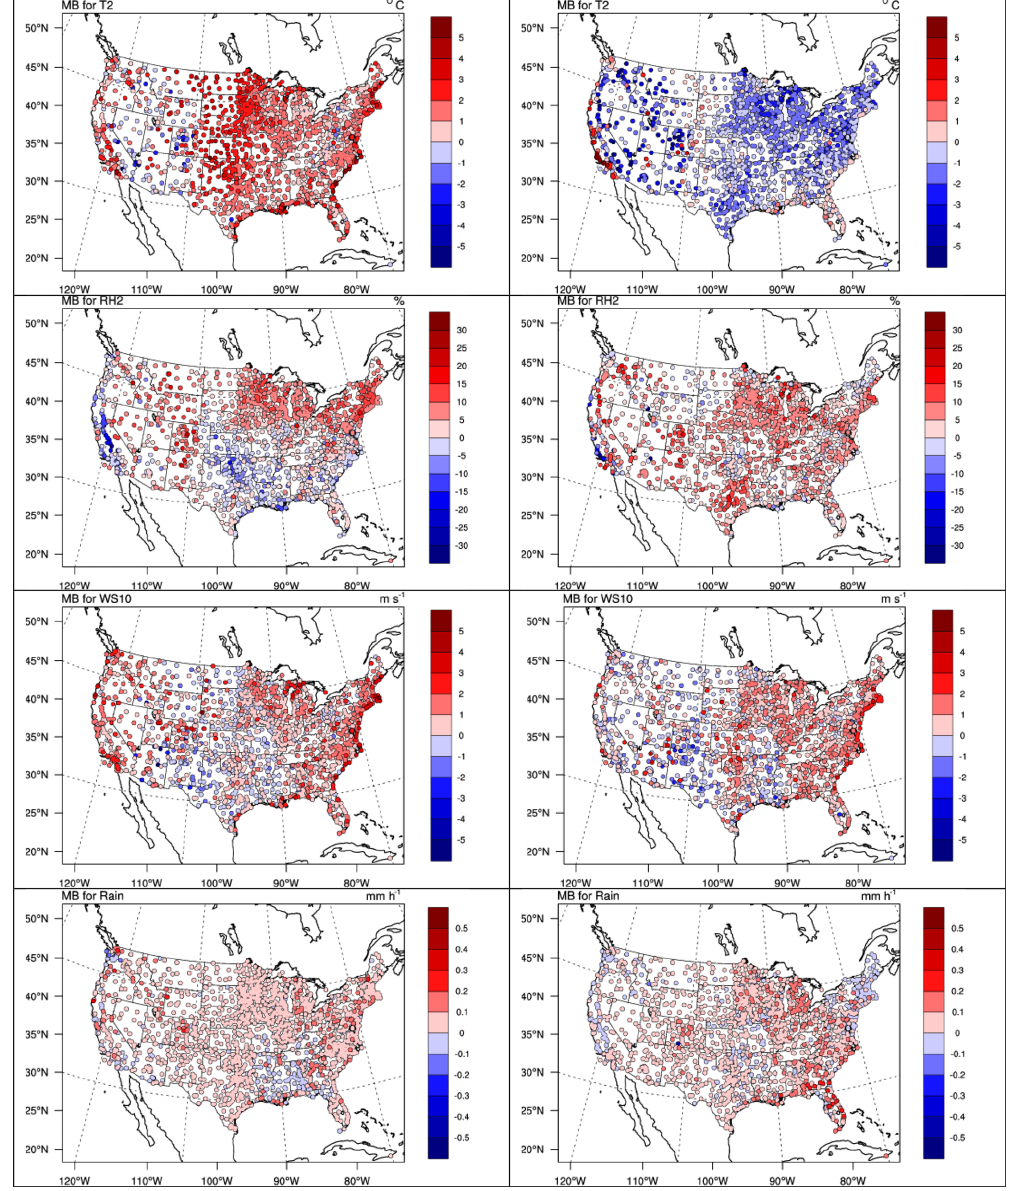
Figure 1. Spatial distributions of 5-year average MBs for 2m temperature (T2), 2m relative humidity (RH2), 10m wind speed (WS10), and hourly precipitation from NCDC for two-way WRF-CMAQ in winter (left column) and summer (right column)